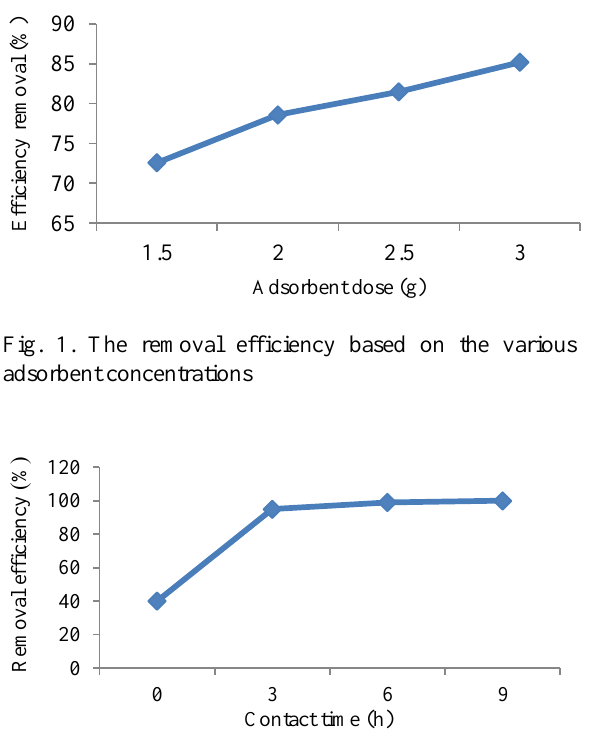
Table 2. Constant of synthetic cadmium adsorption model by adsorbent Freundlich Langmuir adsorption adsorption isotherm